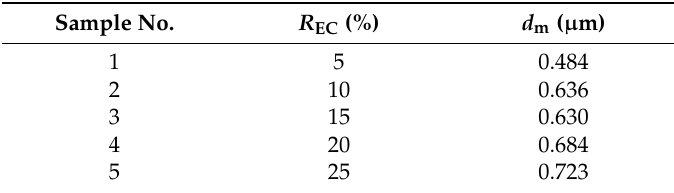
Table 5. Mean diameter of capsules prepared by different amounts of emulsifier. Sample No.